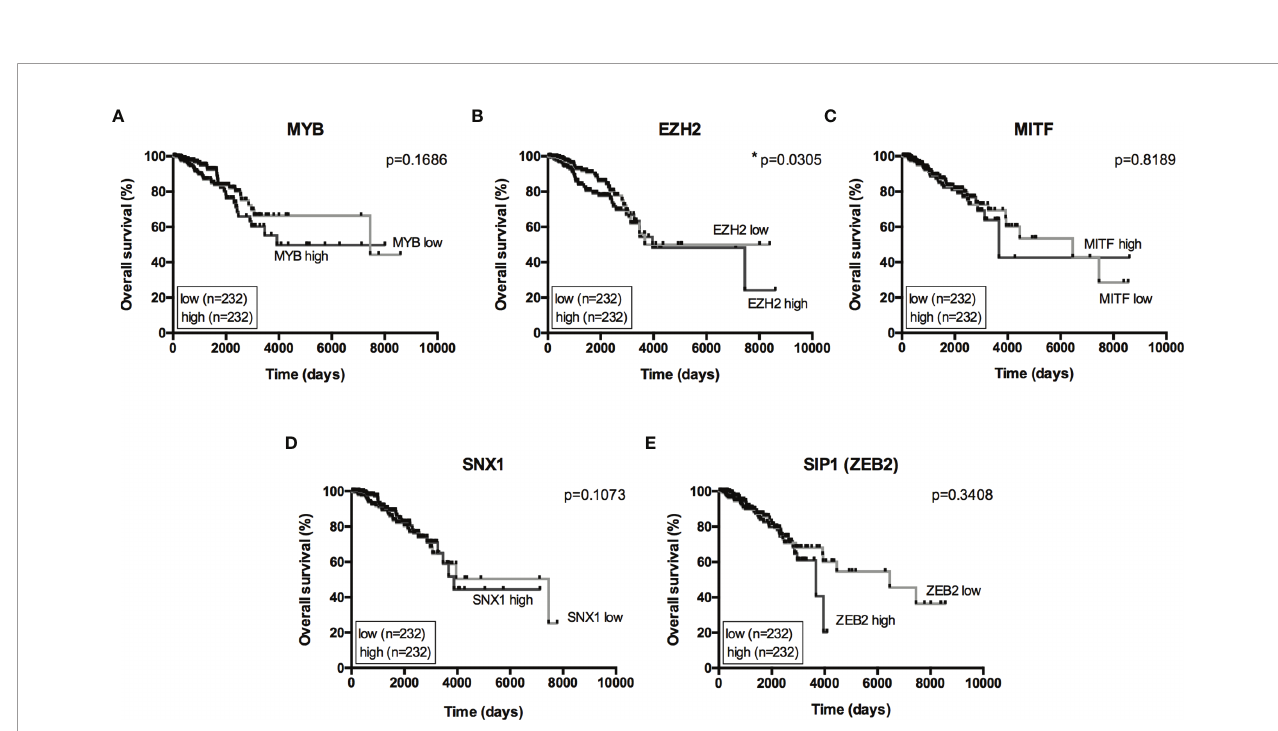
FIGURE 4 | Overall Survival analysis from miRNome targets. Kaplan-Meier curves for overall survival in the TCGA-BRCA dataset with low- and high-expression of (A) MYB , (B) EZH2 , (C) MITF , (D) SNX1 and (E) SIP1(ZEB2) . Expression levels from LUMA, LUMB, HER2 and BASAL subtypes were determined as low or high based on quartile analysis. Statistical differences show poor overall survival (higher risk) for patients with a speci fi c mRNA expression. *p <